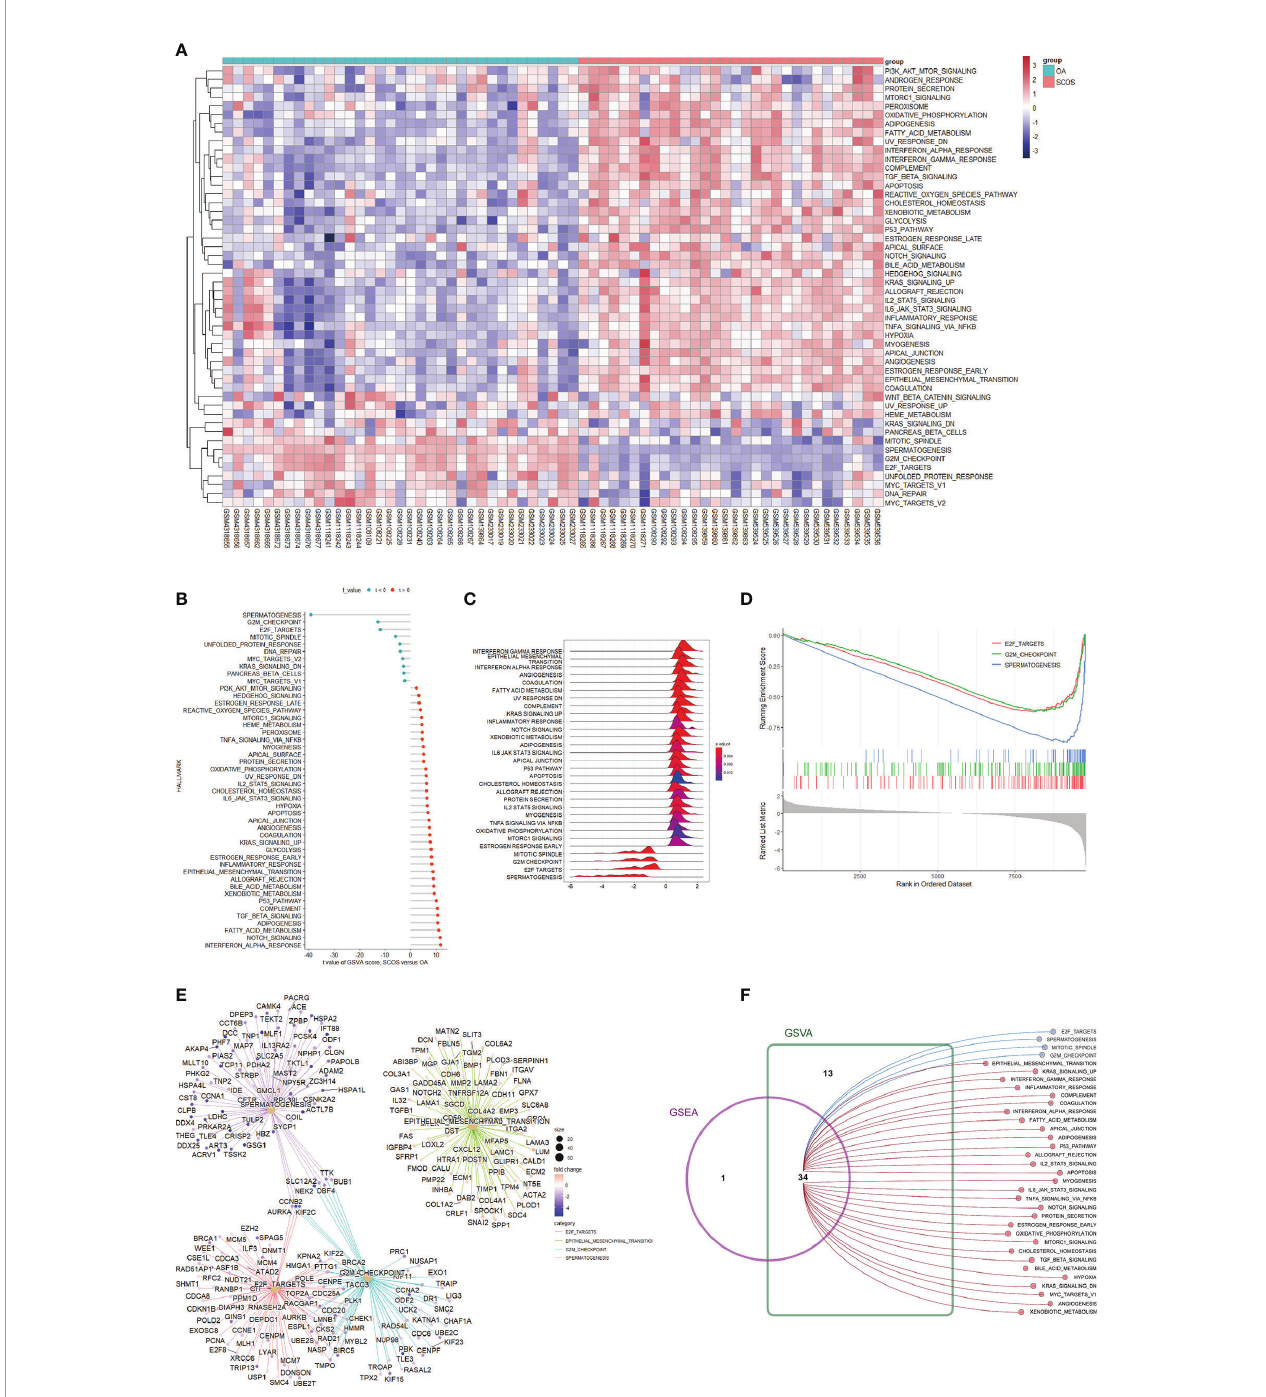
FIGURE 10 | GSEA and GSVA uncovering enriched hallmark pathways in SCOS. (A) The heatmap indicating speci fi c hallmark pathways and testicular tissue samples determined by GSVA enrichment. (B) The lollipop plot showing dysregulated hallmark pathways in SCOS acquired by GSVA enrichment. (C) The ridgeplot visualizing the aberrantly expressed hallmark pathways in SCOS determined by GSEA enrichment. (D) The gseaplot identifying the three most signi fi cantly enriched hallmark pathways between SCOS and OA testicular tissue samples. (E) The cnetplot showing speci fi c genes enriched in different aberrantly expressed hallmark pathways. (F) GSEA and GSVA for signi fi cantly enriched hallmark pathways in SCOS. GSEA, gene set enrichment analysis; GSVA, gene set variation analysis; OA, obstructive azoospermia; SCOS, Sertoli cell-only